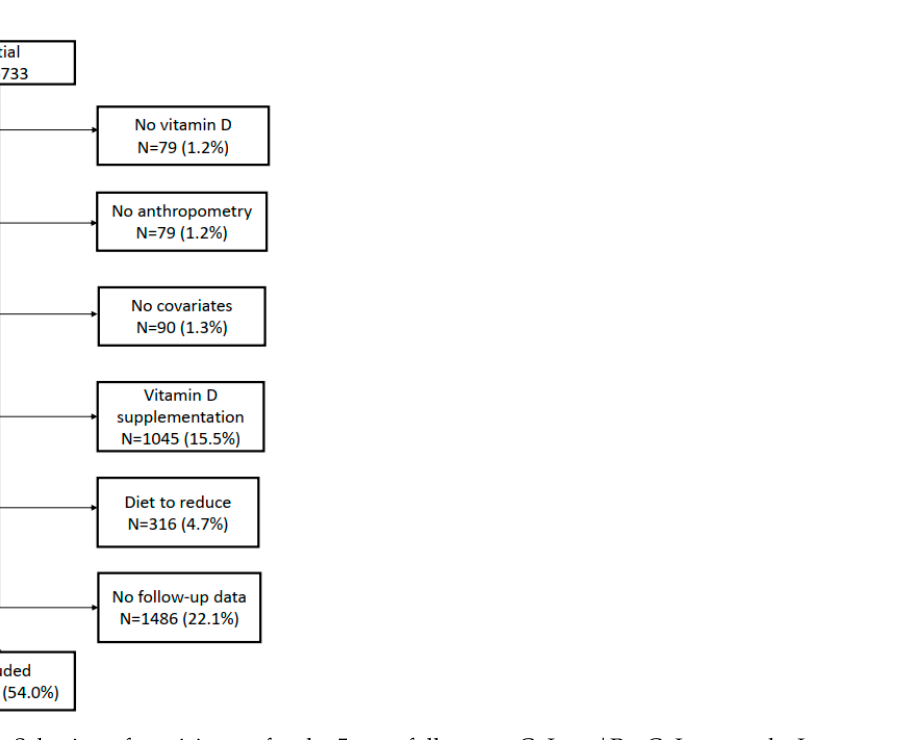
Figure 1. Selection of participants for the 5-year follow-up, CoLaus|PsyCoLaus study, Lausanne, Switzerland.